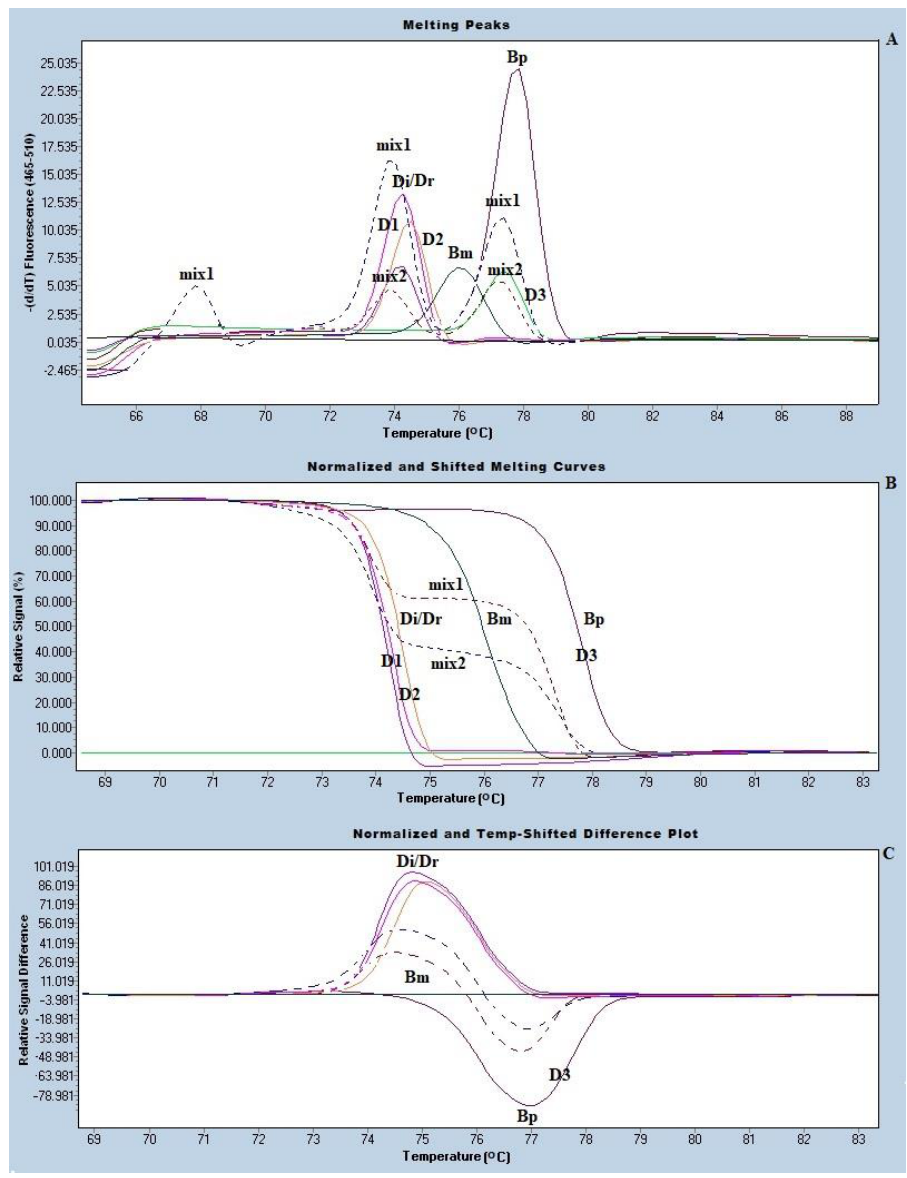
Figure 3. The real time PCR with High Resolution Melting (HRM) analysis for species identification of the trapped mf, ( A ) melting peaks, ( B ) normalized difference curves, and ( C ) the normalized and temperature shifted difference plot of the amplified product of a positive control, i.e., B. malayi , B. pahangi , and D immitis / D. repens and the mf positive dog samples. D1 − 3 representative DNAs from 119 microfilaria-positive dog blood samples. mix1 and mix2 represented mix infections (represented with a dot